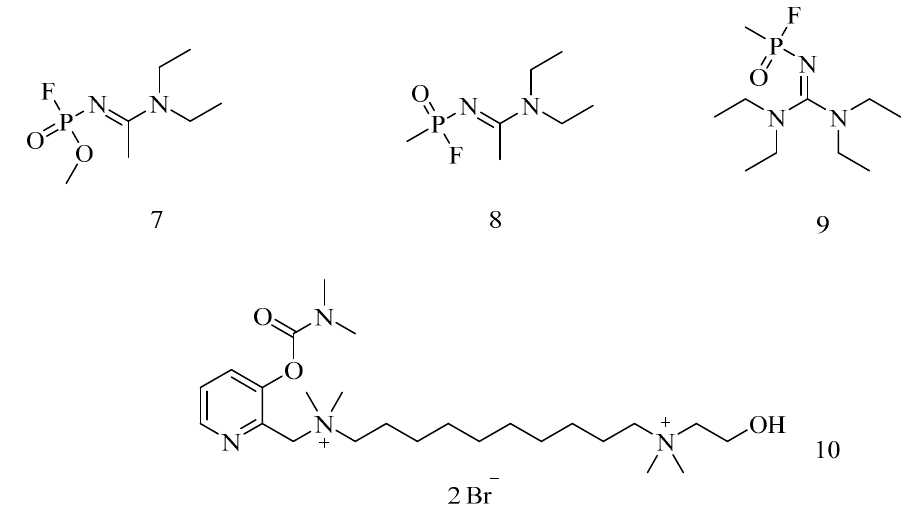
Figure 4. Some considered structures for Novichok Agents according to the Chemical Weapons Convention (CWC).